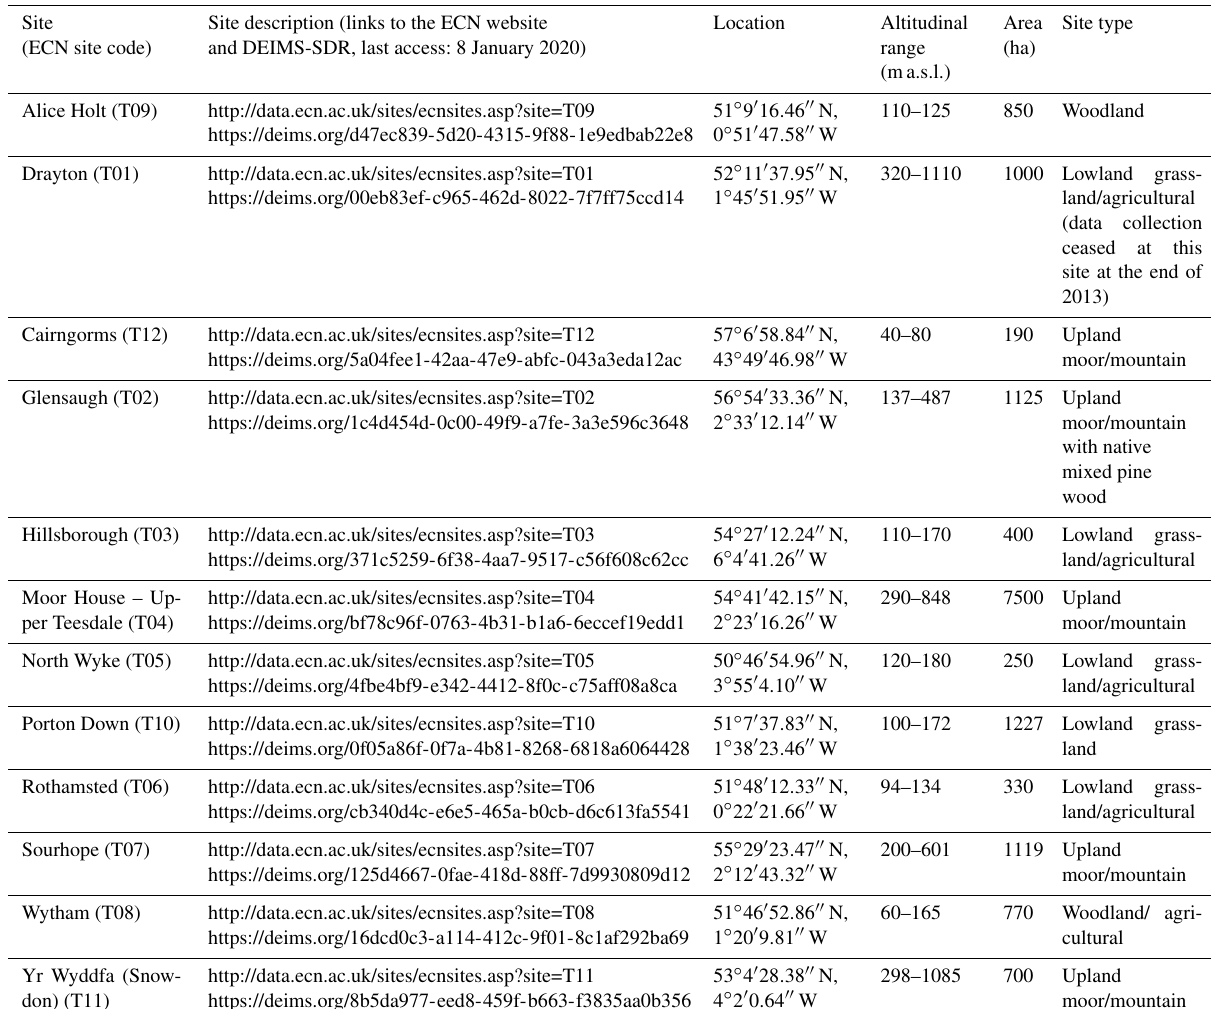
Table 1. ECN terrestrial sites. Site (ECN site